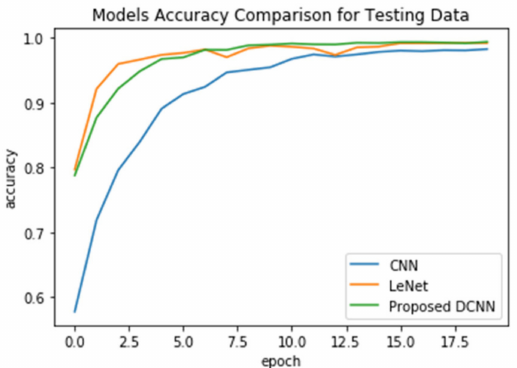
Figure 10. Accuracy Comparison of CNN, LeNet, and the Proposed DCNN on the Pashto Charac- ters Dataset.